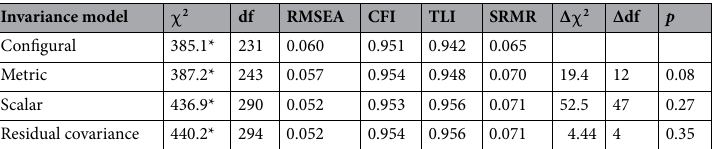
Table 4. Measurement invariance tests of the modified 1-factor model for the Stroke-Specific Quality of Life Scale across time (N = 184). * p < 0.01; χ 2 = chi-square; df = degree of freedom; RMSEA = root mean square error of approximation; CFI = comparative fit index; TLI = Tucker-Lewis index; SRMR = standardized root mean square residuals; Δ χ 2 = chi-square difference.